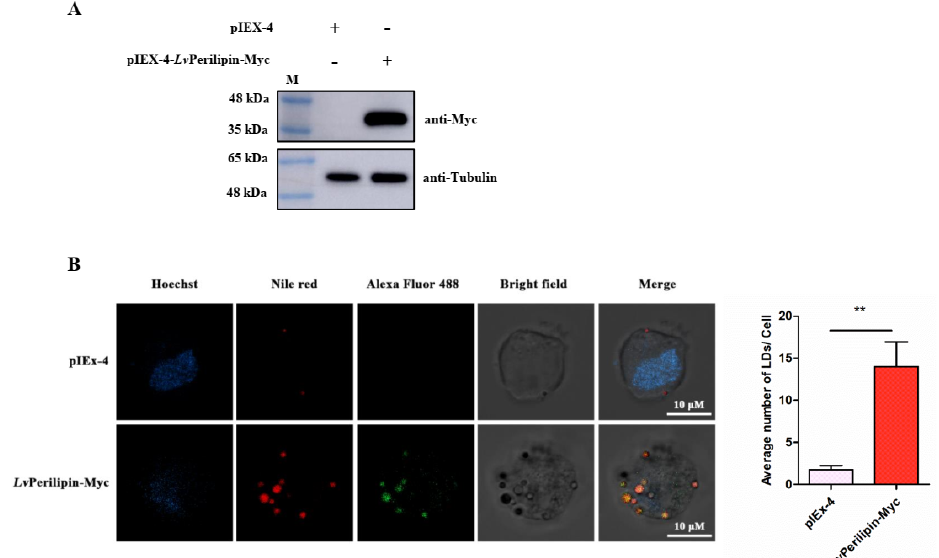
Figure 4. Lv Perilipin facilitates LDs biogenesis. ( A ) Western blotting analysis indicated that Myc- tagged Lv Perilipin was successfully expressed in High Five cells. ( B ) Immunofluorescence analysis revealed that Lv Perilipin colocalized with LDs and promoted LDs biogenesis. High Five cells were transfected with Myc- Lv Perilipin. After transfection for 36 h, immunofluorescence analysis was performed with primary mouse anti-Myc and Alexa Fluor 488 anti-mouse antibodies. The cells were then stained with Nile red to mark LDs. Finally, a confocal laser-scanning microscope was used to observe the cells. The number of LDs puncta in each cell was counted. Statistical significance was set at ** p < 0.01. Scale bars = 10 μ m.